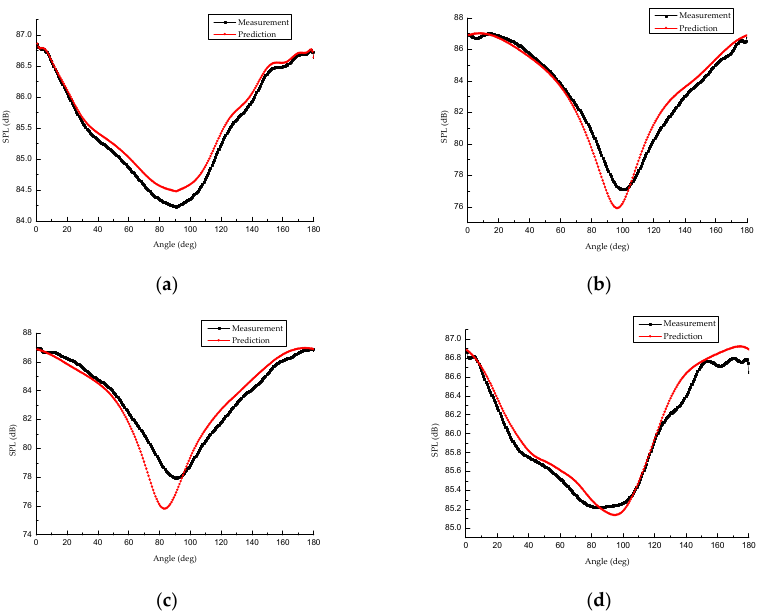
Figure 9. SPL over the angle range 0–180° at four microphone locations by the minimum data fluctuation selection method: ( a ) No.1 installation hole; ( b ) No.2 installation hole; ( c ) No.3 installation hole; ( d ) No.4 installation hole.